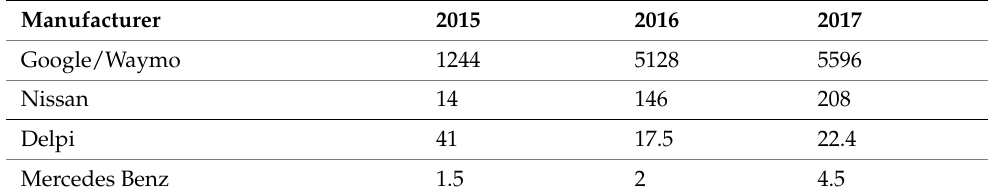
Table 6. Behavior of AVs over the distance